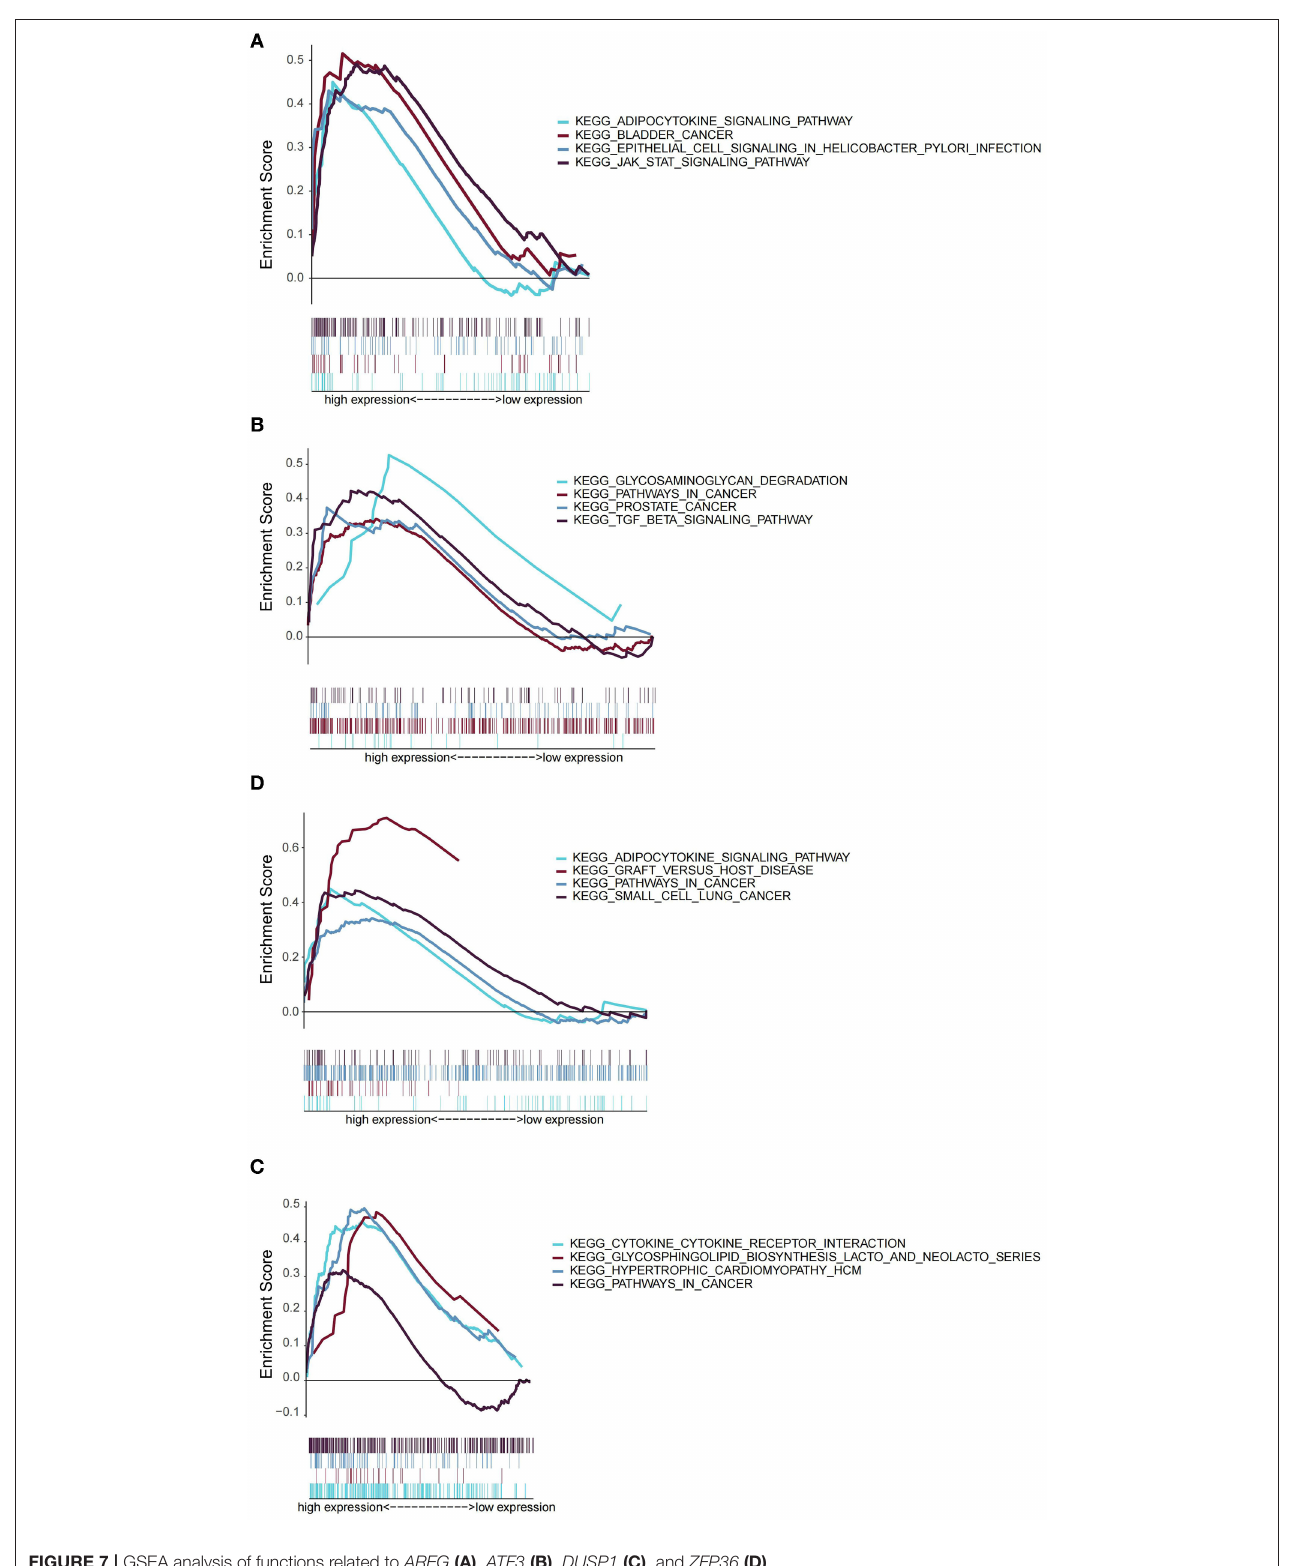
Frontiers in Medicine |